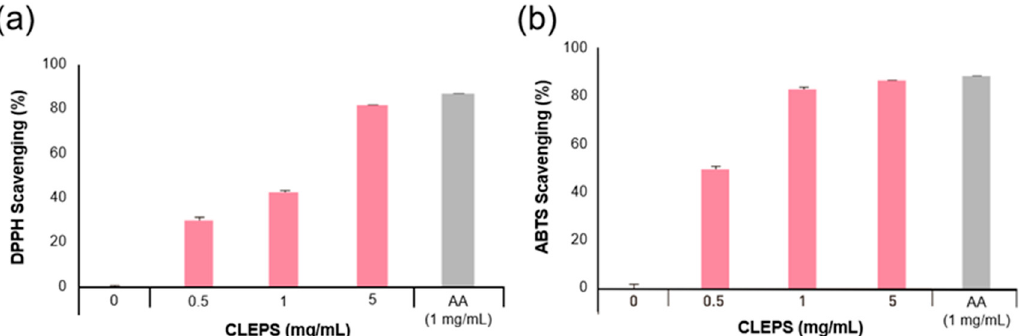
Figure 2. Anti-oxidation efficacy of CLEPS via DPPH ( a ) and ABTS ( b ) assays. p > 0.05 vs. 0 mg/mL.